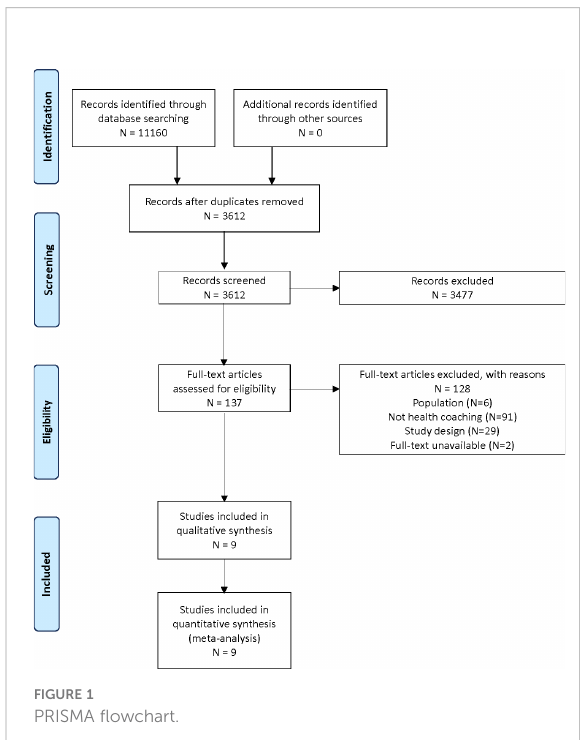
FIGURE 1 PRISMA fl